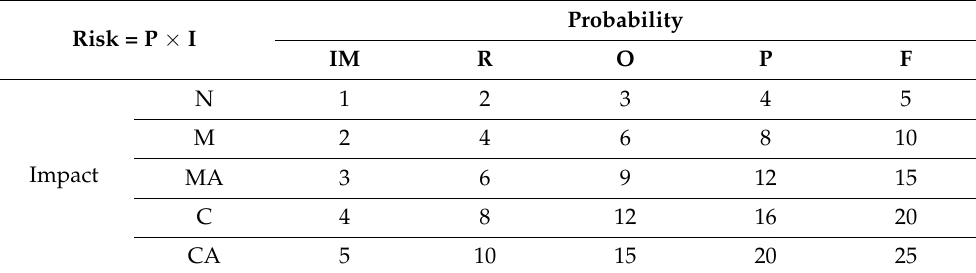
Table 4. Risk matrix with